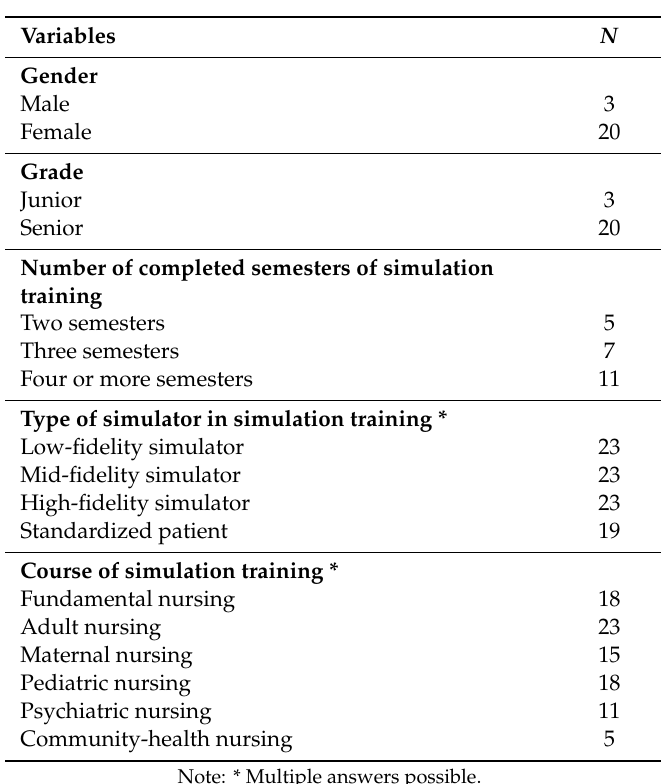
Table 1. General participant characteristics ( N = 23).